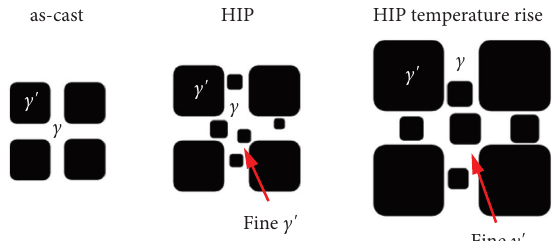
Figure 12: Schematic of morphology evolution of the as-cast microstructure after